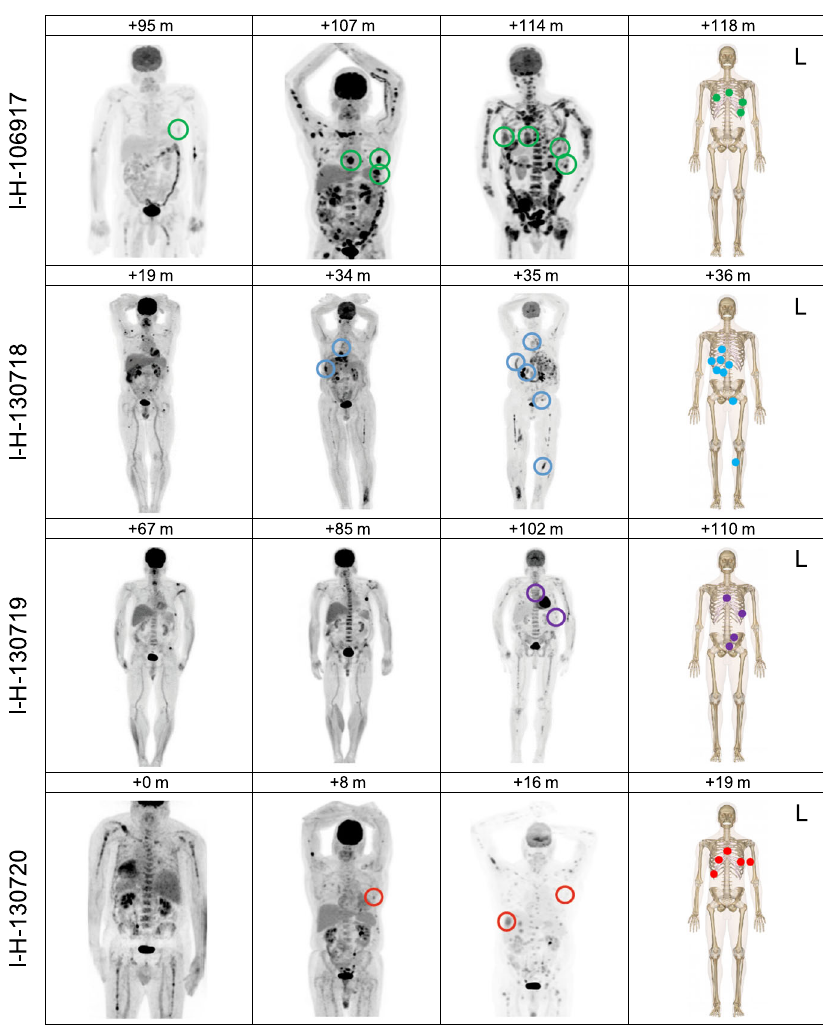
Fig. 7 Tracking of biopsied lesions through the disease course by FDG-PET/CT. Biopsy sites and FDG-PET/CT correlates on Maximum Intensity Projection images for each patient arranged by the number of months following diagnosis (m = months). All included scans show phases of active disease. Biopsy sites were only annotated on FDG-PET/CT if identi fi ed on Radiologist review. L =